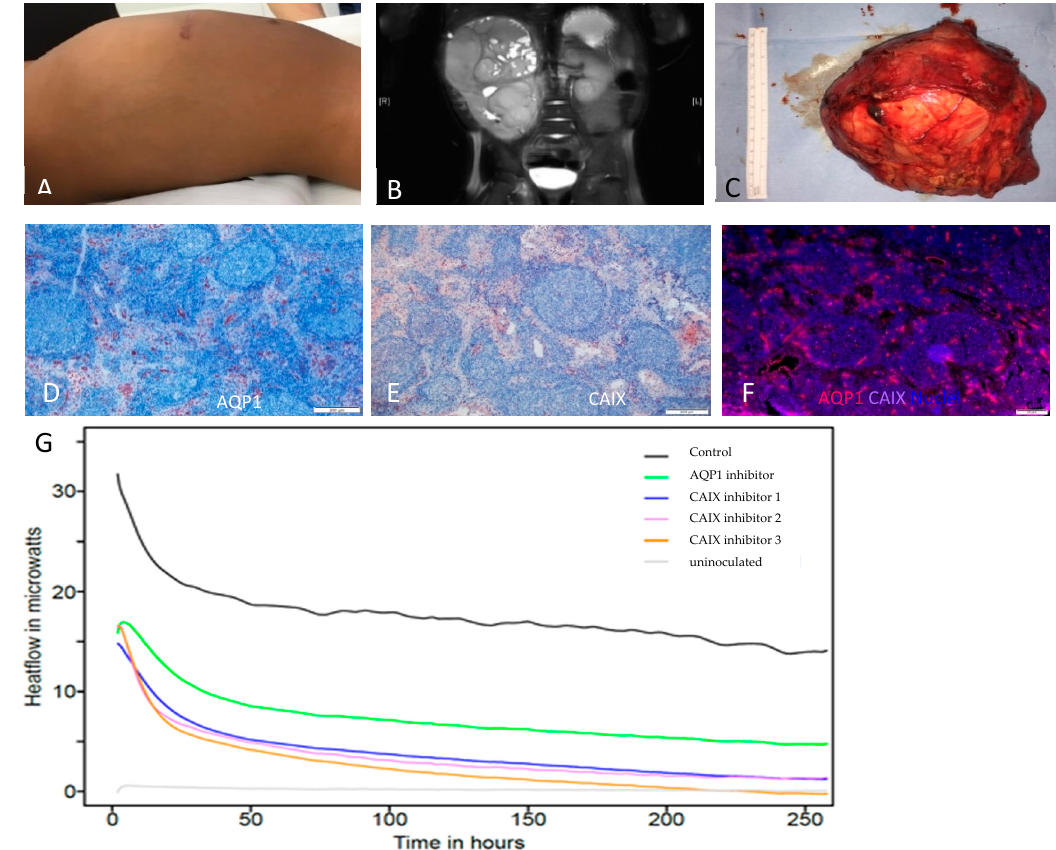
Figure 1. Clinical presentation ( A ) The child presented with a large abdominal mass, which was not reduced in size after initial chemotherapy. The scar was a result of the initial surgical biopsy. ( B ) MRI of primary clear cell sarcoma of left kidney following chemotherapy. Despite few necrotic areas the tumor is largely intact and appears to be vital. ( C ) Large tumor after resection. Immuno-staining ( D AQP1 IHC, E : CAIX IHC, F : AQP1 and CAIX IF stainings) The response to the specific inhibitors corresponded with the protein expression profiles of AQP1 (mostly in vibrovascular septae and vessels and CAIX (most strongly within tumor nests). Microcalorimteric measurements ( G ) Microcalorimetric measurements showed a decrease metabolic activity under treatment with AQP and CAIX inhibitors compared to medium control. (Control – medium, Drug 1—AQP1 inhibitor TEA, Drug 2—FC8-325A, Drug 3—FC8-207A, Drug